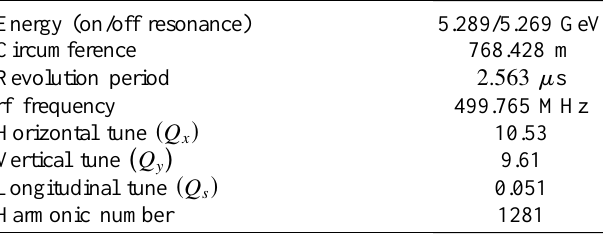
Parameters of the CESR storage